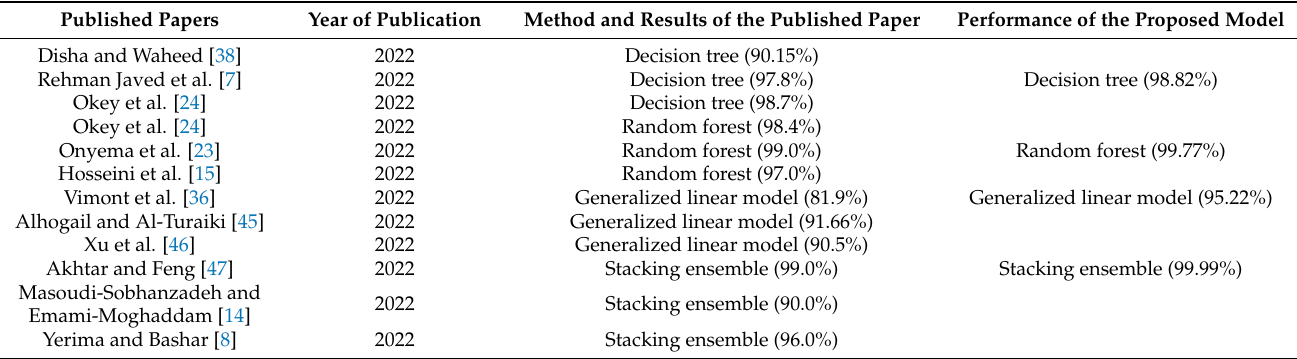
Table 3. Comparison of the obtained results with existing published